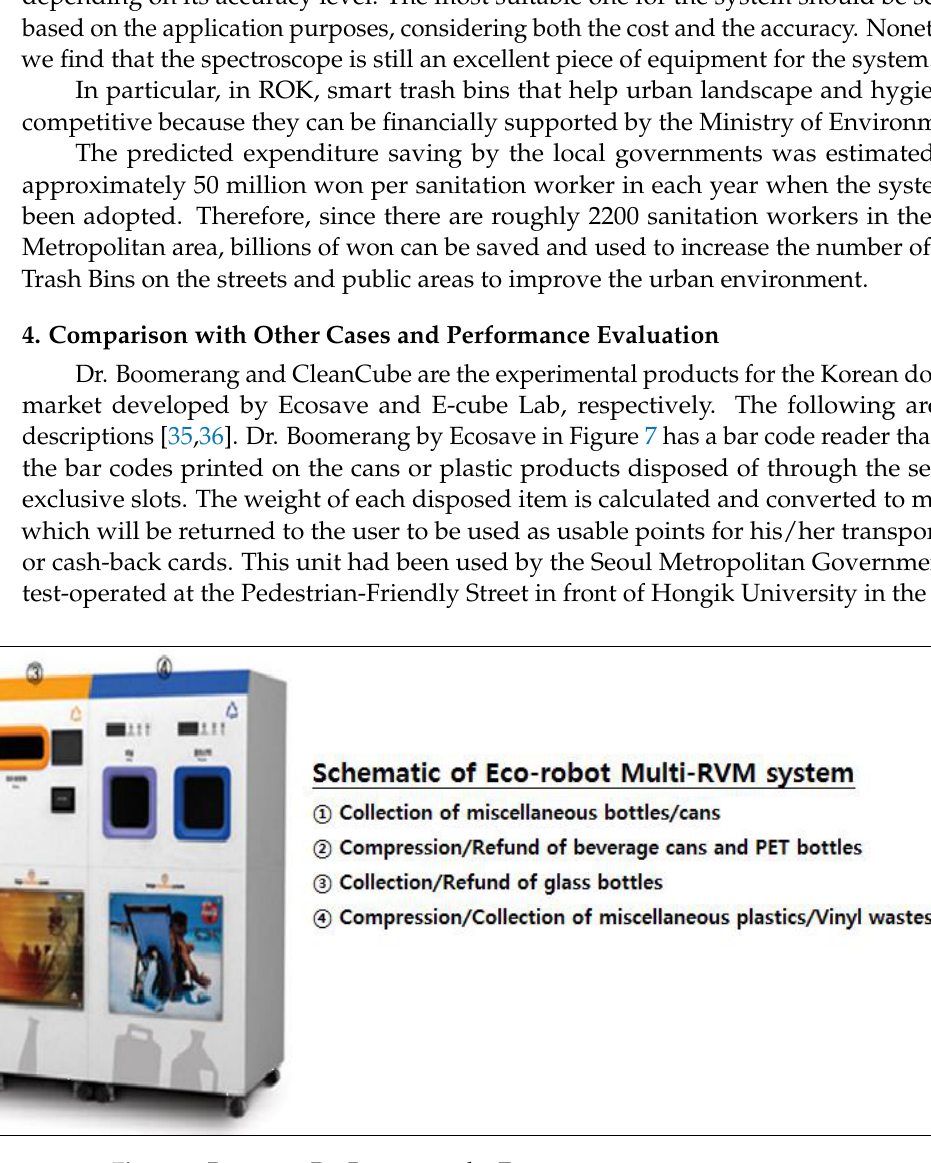
Figure 7. Prototype Dr. Boomerang by Ecosave.